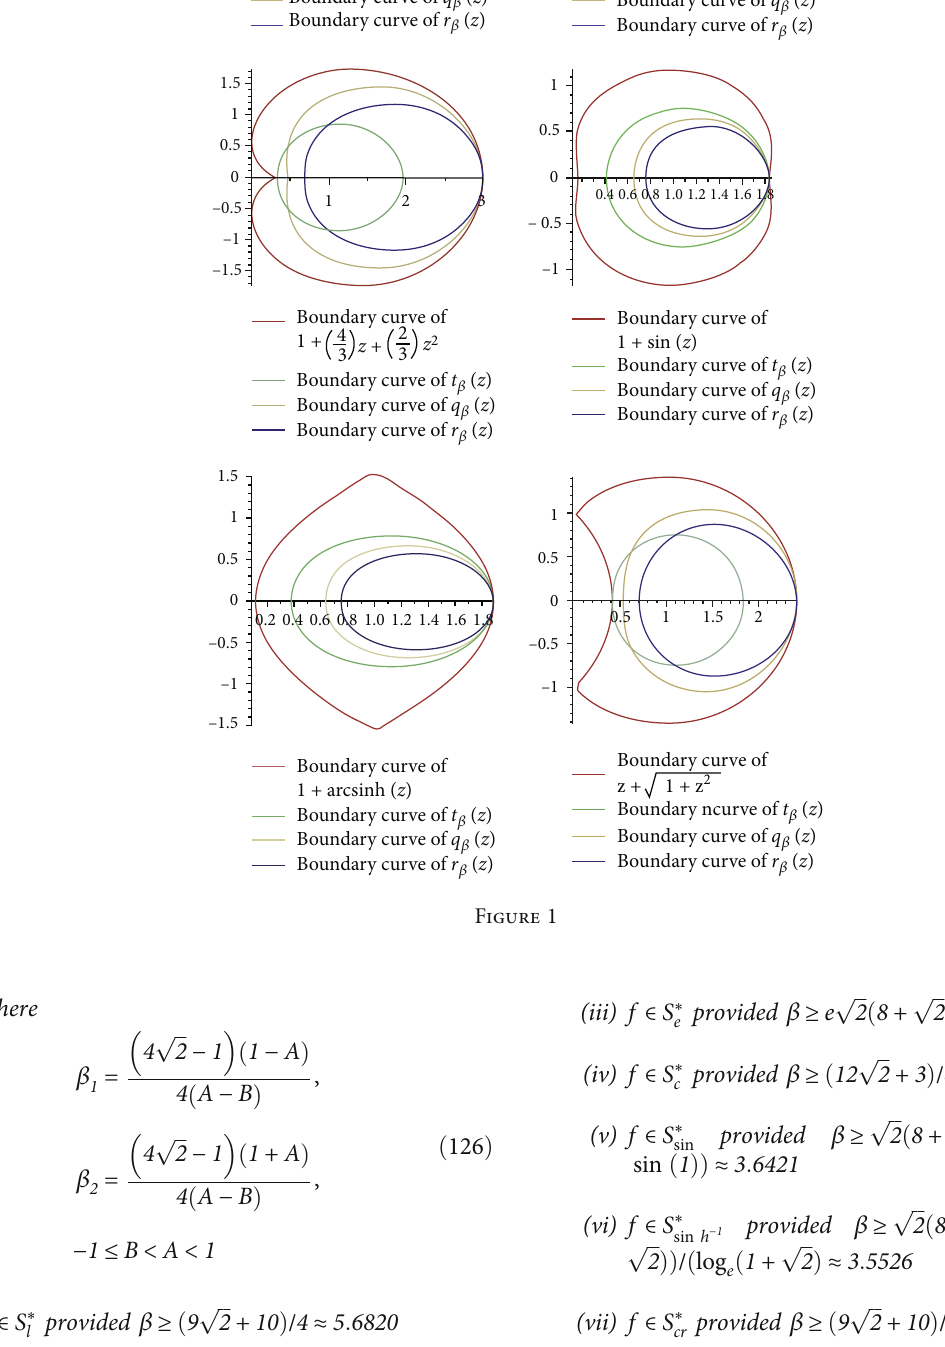
Boundary curve of t Boundary curve of q 𝛽 ( z ) Boundary curve of r